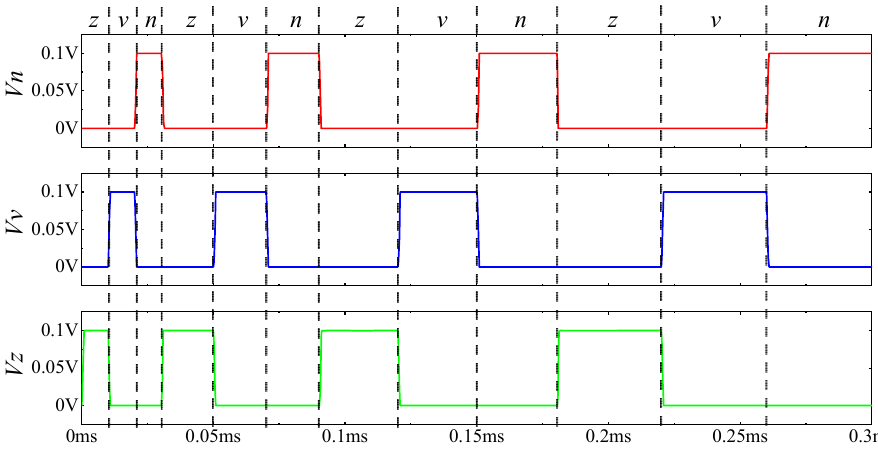
Figure 7. Simulation results of character recognition network circuit and the number of false recognition pictures in the circuit.